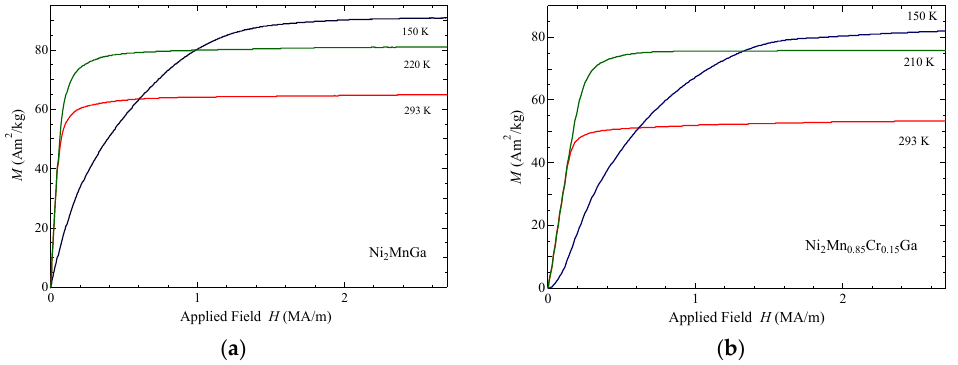
Figure 3. The magnetisation M of the ( a ) x = 0.00 alloy; and ( b ) x = 0.15 alloy. Blue: martensite phase, Green: premartensite phase, Red: austenite phase.